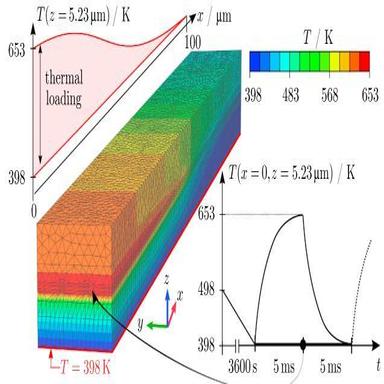
The right hand side diagram shows the temperature history within the conductor paths. After an initial homogeneous cooling from 498 K to 398 K, 50 inhomogeneous thermal load cycles are applied reaching a maximum temperature of 653 K. The left image illustrates the temperature distribution after heating. Figure adopted from.